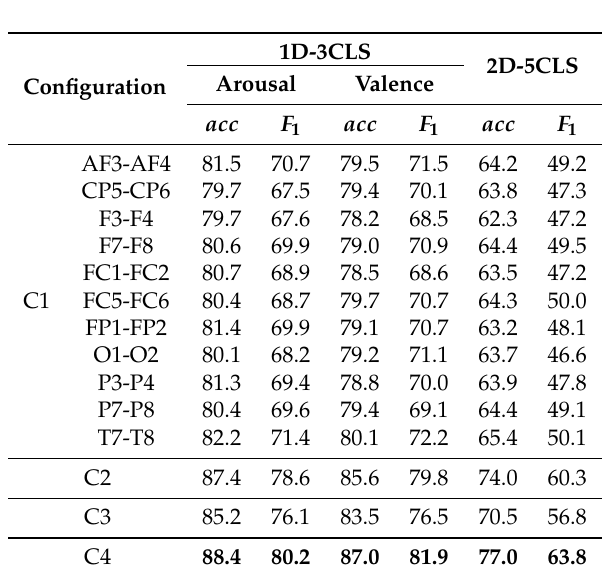
Table 9. The results of the channel-based evaluation analysis computed for the 1D-3CLS and 2D-5CLS after excluding the feature vectors that correspond to the neutral class. Bold font is used to indicate the highest acc and F 1 values obtained for each combination of emotion labeling scheme and EEG channel configuration.